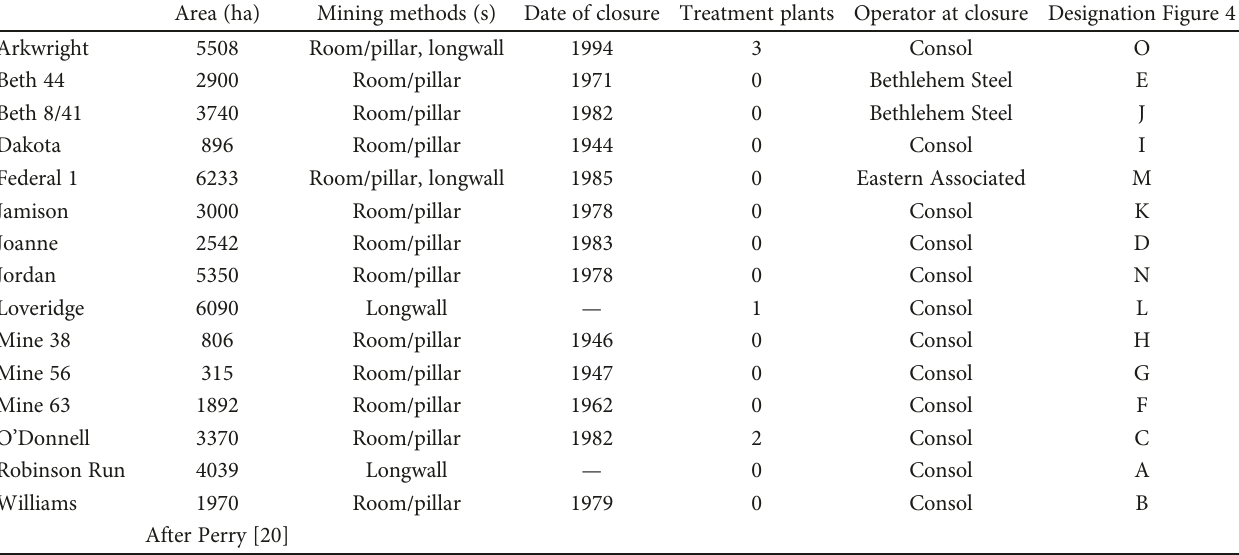
Figure 4: Underground mines, monitoring wells, pumping wells, and treatment plants mentioned in or relevant to the text. Currently active mines are shown in Table 1: Mines in the Fairmont Coal fi eld and nearby areas. See Figure 4 for locations. Area (ha) Mining methods (s) Date of closure Treatment plants Operator at closure Designation Figure 4